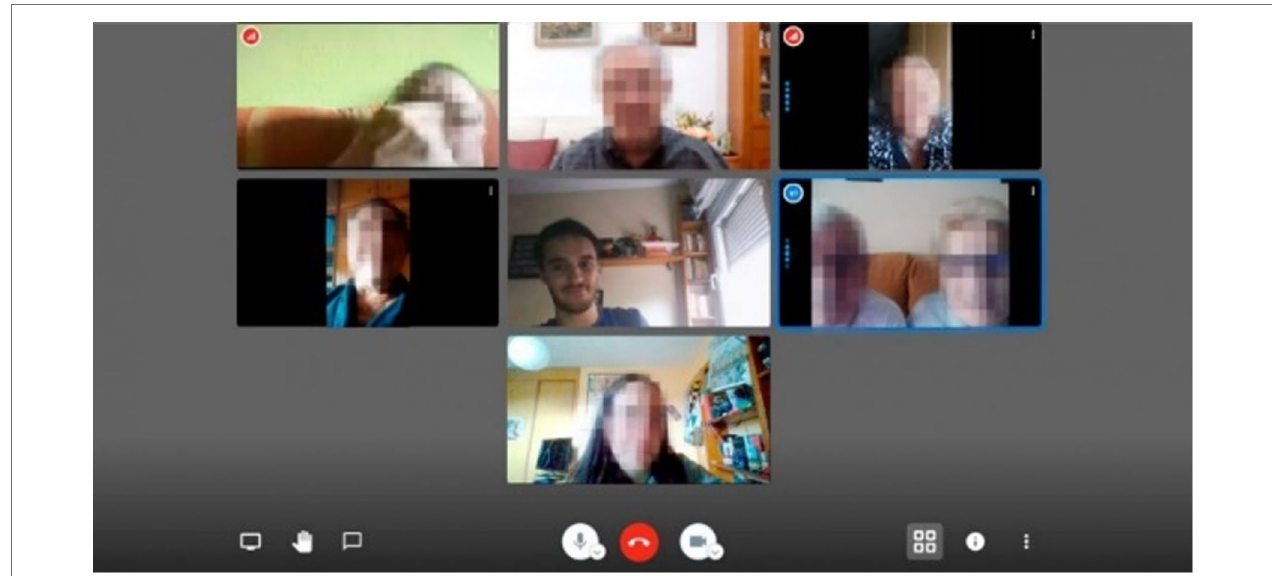
FIGURE 1 | One of the talks on Jitsi with advanced students of information and communication technology